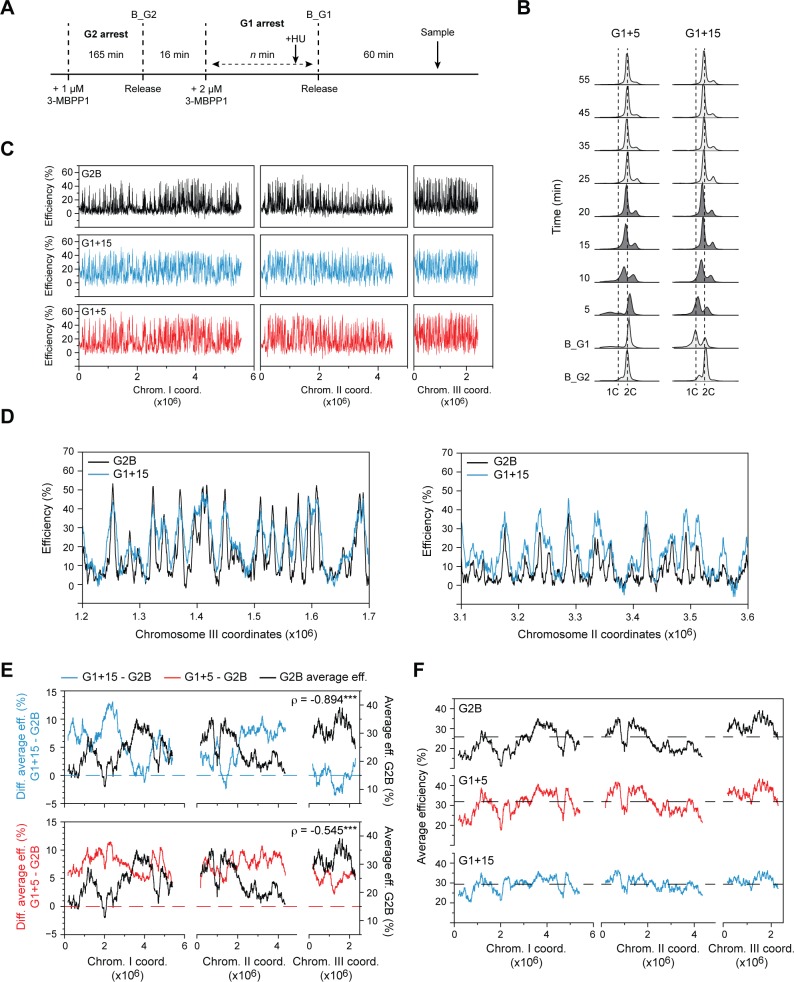
The timing of CDK availability for the G1/S transition modulates the regional organization of genome duplication.A) Experimental design for determining the replication profiles in Cdc13-Cdc2 cells with a delay in CDK availability. n represents 20 min (G1+5) or 30 min (G1+15). For array experiments, HU was added to the cells 10 min before the release from the 2 μM 3-MBPP1 inhibitor treatment (B_G1). Cells were harvested 5 min before (unreplicated DNA) and 60 min after this release, after S phase is completed in a sample without HU (see B). B_G2: G2 block. B_G1: G1 block. B) DNA content analysis of G1+5 and G1+15 cells undergoing a synchronous S phase. Experimental procedures were as in A, but without HU treatment. Samples in which cells are undergoing DNA replication are shown in dark gray. B_G2 and B_G1 are as in A. G1+5 cells are initially arrested in G2 with a 2C DNA content (B_G2), and they maintain this DNA content during the 2 μM inhibitor treatment that extends G1 (B_G1). Cells begin replicating by 5 min after the release from G1, leading to a rightward shift in the peak. By 10 min, cytokinesis has started to occur, concomitant with replication, resulting in the presence of both 2C and 4C peaks. G1+15 cells are initially arrested in G2 with a 2C DNA content (B_G2). In contrast to the G1+5 condition, they begin to divide during the additional 10 min of the G1 arrest (B_G1), giving rise to a 1C peak. Cells enter S phase by 5 min after the release from G1 arrest, resulting in a rightward shift of the peaks. See Materials and Methods for additional details for the interpretation of flow cytometry profiles. C) Origin usage profiles of Cdc13-Cdc2 cells released from G2 (G2B) or undergoing short G1 extensions (G1+15 and G1+5). Note that all origin efficiency profiles were assessed in 24 mM HU (see Materials and Methods for more details). x-axis: chromosome coordinates, y-axis: origin efficiencies. For full detailed profiles and one-to-one comparisons of origin efficiencies, see S2A and S2B Figs. D) Detailed views of origin efficiencies in representative regions of the genome for G2B (black) and G1+15 (blue). x-axis: chromosome coordinates, y-axis: origin efficiencies. E) Regional analyses of the changes in origin efficiencies between the G2B, G1+15, and G1+5 replication programs. Top panel: Differences of the average origin efficiencies (G1+15 - G2B) determined in continuous windows of 1000 probes (~250 kb) (blue, scale on left y-axis). The profile of average origin efficiencies in G2B is indicated in black (scale on right y-axis). Bottom panel: Differences of the average origin efficiencies (G1+5 - G2B) determined in continuous windows of 1000 probes (~250 kb) (red, scale on left y-axis). The profile of average origin efficiencies in G2B is indicated in black (scale on right y-axis). Dashed lines represent 0% efficiency changes. x-axis: chromosome coordinates. The Spearman’s rank correlation coefficients (ρ) comparing the differences in origin usage vs. average origin efficiencies in G2B are indicated. This shows very strong and moderate negative correlations for G1+15 - G2B vs. G2B and G1+5 - G2B vs. G2B, respectively. ***: p-value < 0.001. F) Regional profiles of replication domains in G2B (black), G1+5 (red), and G1+15 (blue). The averages of origin efficiencies were determined for continuous windows of ~250 kb (1000 probes). Dashed lines indicate the average efficiency of all of the origins in each program (G2B: 26.4%; G1+5: 31.9%; G1+15: 29.4%). Data for the G2B conditions are as in E. x-axis: chromosome coordinates, y-axis: average origin efficiencies.